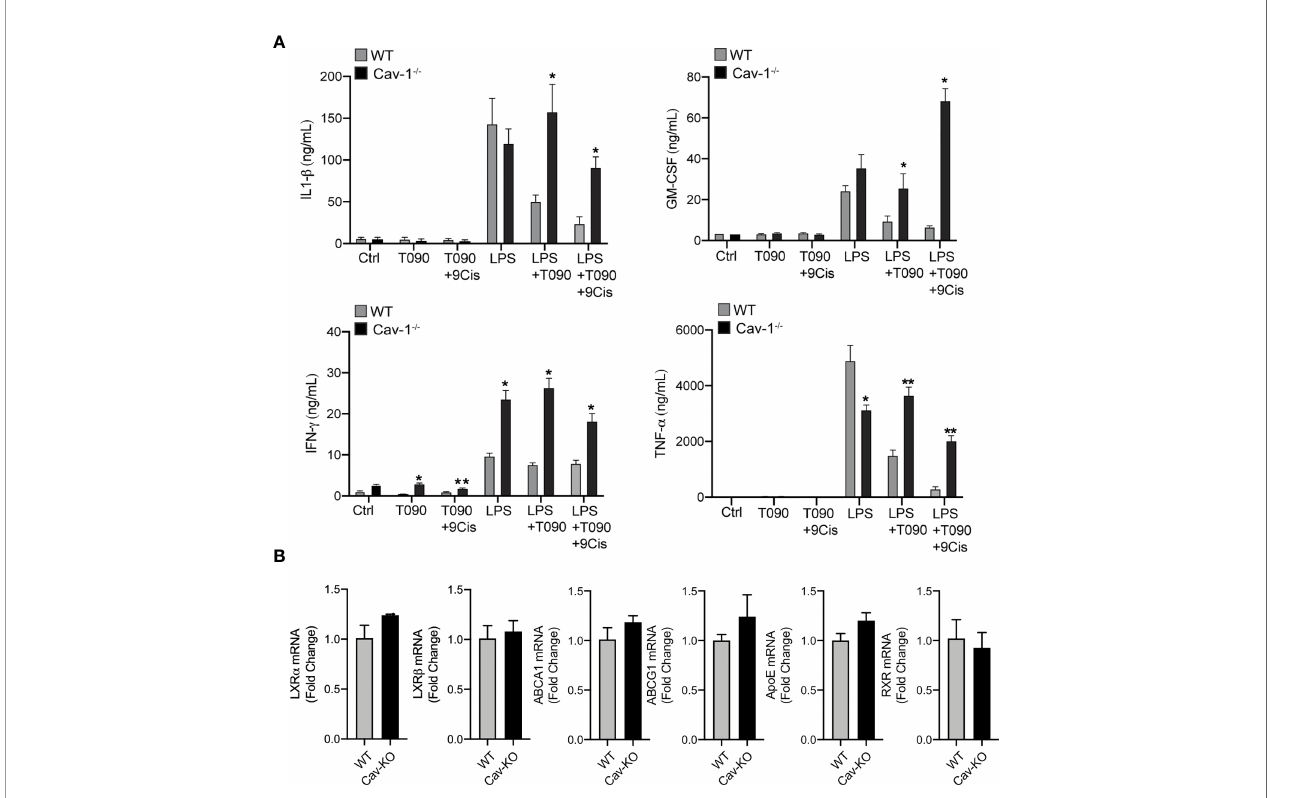
FIGURE 5 | Cav-1 in fl uences anti-in fl ammatory effects of LXR in peritoneal macrophages. (A) Cytokine production in culture media of peritoneal macrophages from WT and Cav-1 -/- mice pre-treated with 1 m M T0901317 and 1 m M 9-Cis Retinoic Acid for 18h hours prior to stimulation with LPS for another 24h. Data represent 3 independent experiments performed in triplicate * P<0.05 , ** P<0.01 (signi fi cantly different from WT in Ctrl conditions). (B) qRT-PCR analysis of LXR a , LXR b , ABCA1, ABCG1 and ApoE mRNA levels in peritoneal macrophages form WT and Cav-1 -/- mice. Data are expressed as relative expression levels and correspond to the means ± SEM from three independent experiments performed in triplicate compared to WT and normalized to